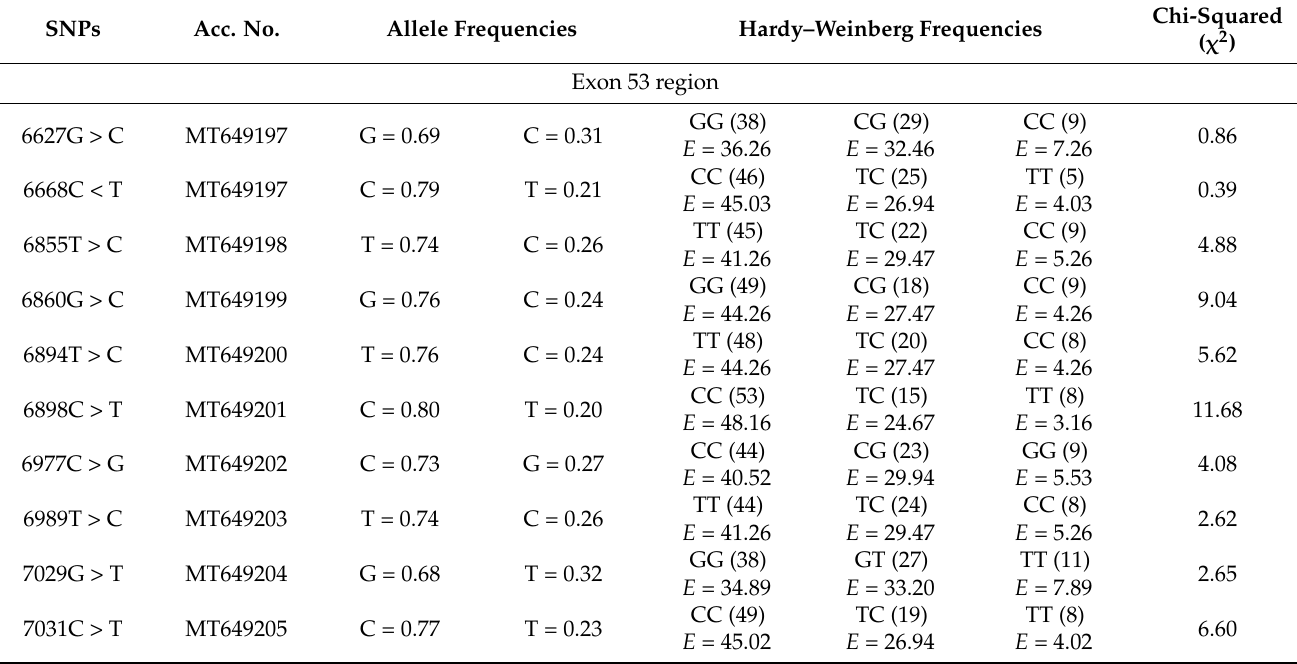
Table 4. Genotype and allele frequencies in single-nucleotide polymorphisms (SNPs) at Exon 53 of the ACAC α gene in Najdi